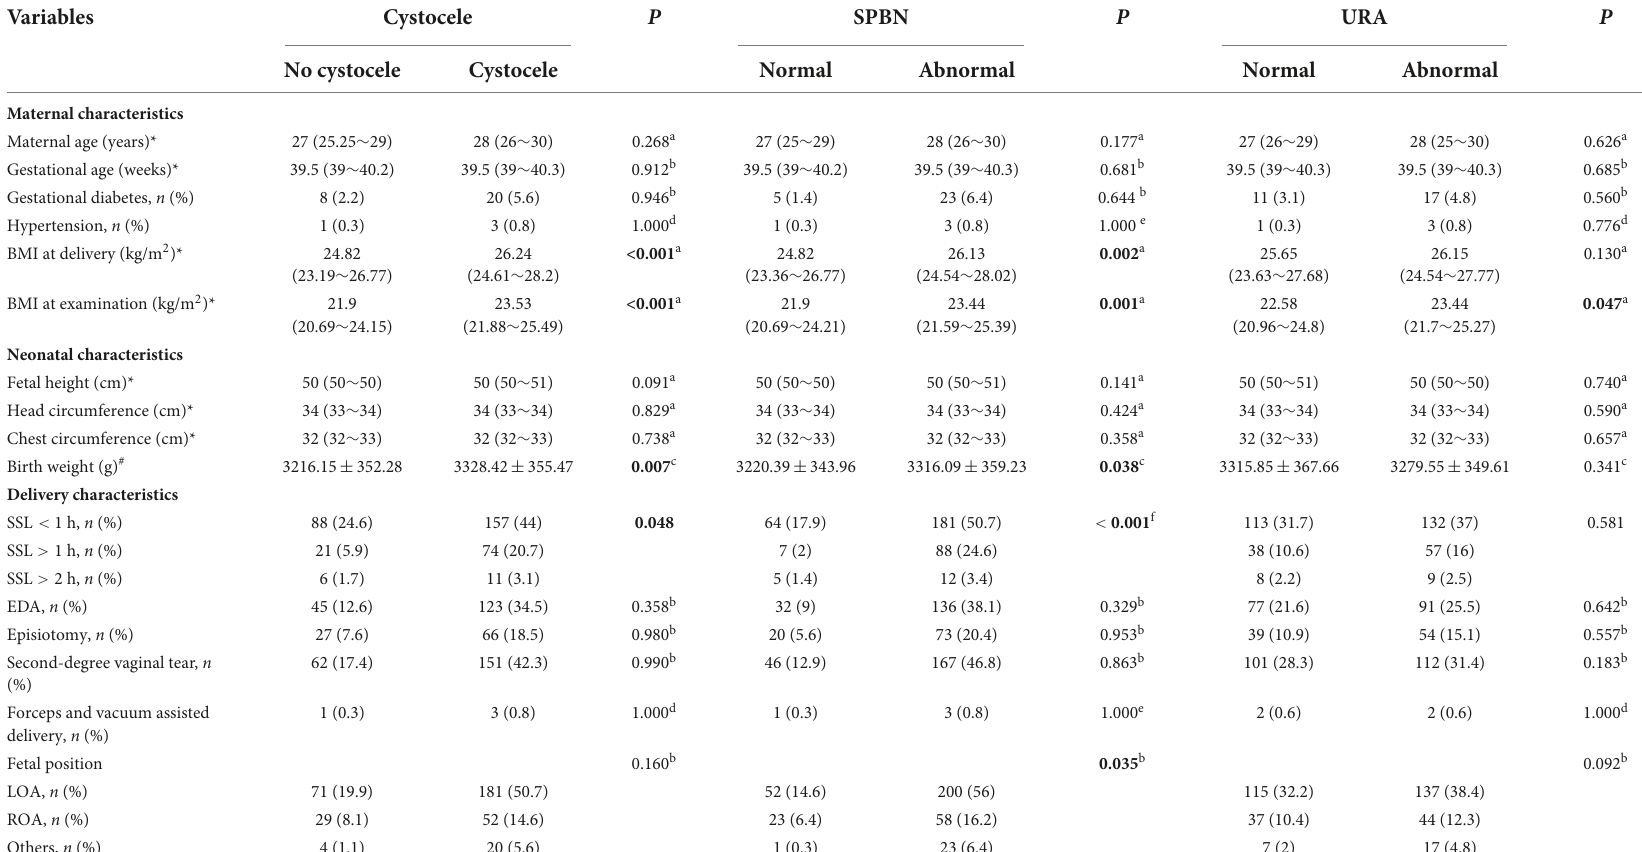
TABLE 1 Analysis of factors associated with cystocele, symphysis pubis to the bladder neck (SPBN), and urethral rotation angle (URA).